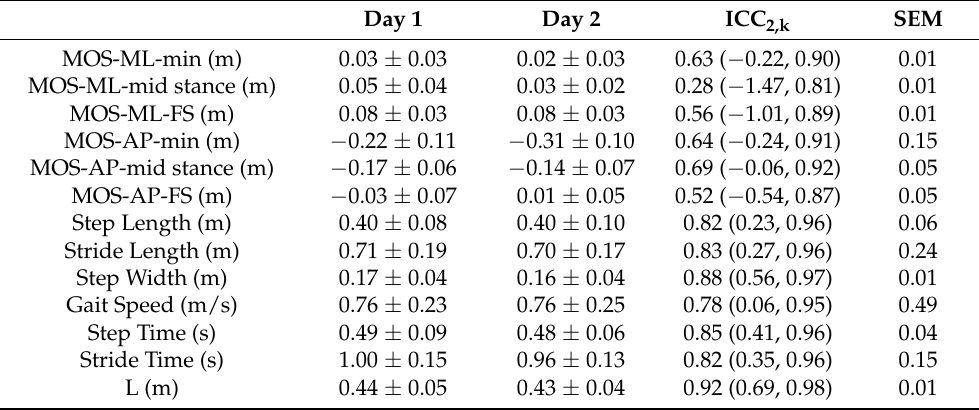
Figure 3. Bland–Altman plots indicate the agreement between MOS variables for ten children with cerebral palsy (CP) calculated using the Kinect V2 and Motion Analysis. The red solid line represents the reference line at the mean, and the two black dashed lines represent the upper and lower limit of agreement. Table 5. Mean ± 1SD (n = 10) values for each MOS and spatiotemporal gait parameters collected by the Kinect V2 on Day 1 and 2, ICC 2,k with 95% confidence intervals for agreement and SEM is provided. FS: foot strike; min: minimum; L: length of the